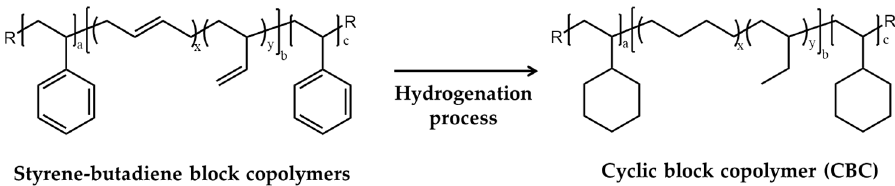
Figure 1. Hydrogenation process for forming a cyclic block copolymer.